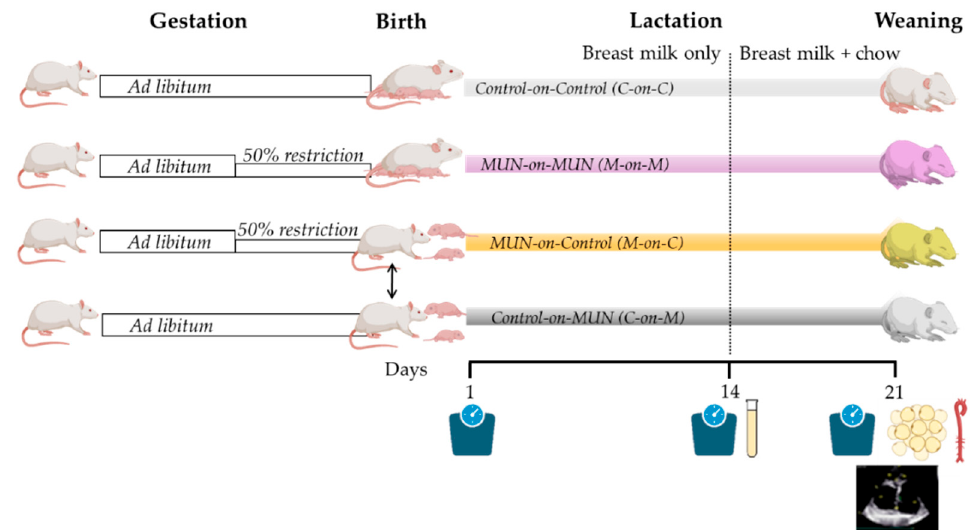
Figure 1. Experimental protocol diagram. MUN, maternal undernutrition during gestation; C-on-C, control pups fostered by a control mother (n = 6 dams); M-on-M, MUN rats fostered by their own mothers (n = 6 dams); C-on-M control rats fostered by a MUN mother (n = 4 dams); MUN-on-C, MUN rats fostered by a control mother (n = 4 dams).